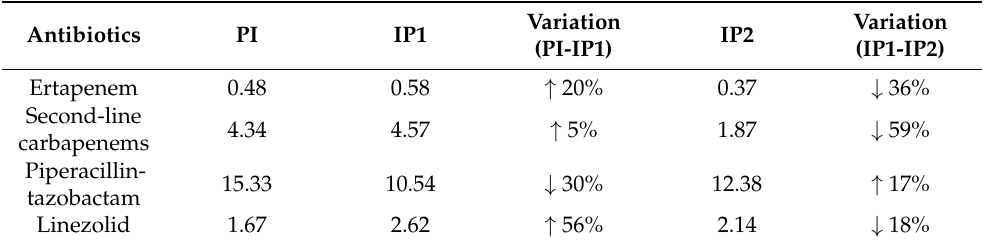
Table 3. Antibiotic DDD 1 adjusted per bed-days. Analysis of the variations among Pre-intervention Period and the two Intervention